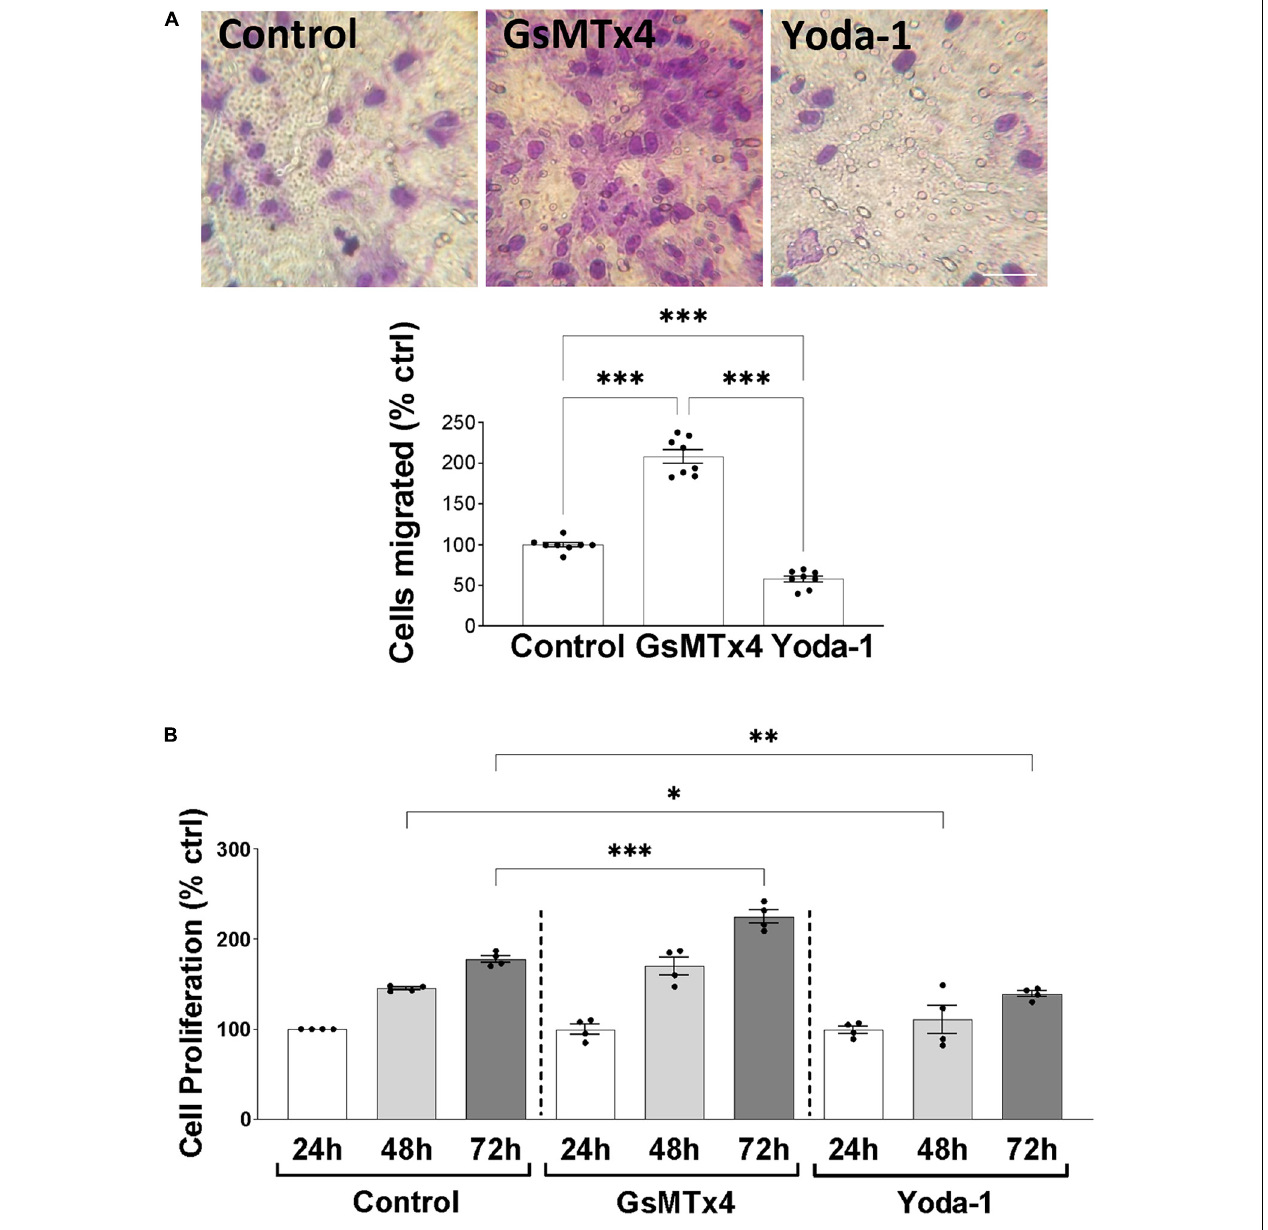
FIGURE 3 | Inhibition of Piezo1 induces MO3.13 oligodendrocyte migration. (A) Representative images and a corresponding bar graph show increased oligodendrocyte migration after inhibition of Piezo1 signaling for 24 h with GsMTx4 (500 nm) (208.4 ± 8.21% vs. control). Agonism of Piezo1 with Yoda-1 (40 µ m) induced opposite effects (58 ± 3.82% vs. control). Data presented as mean ± SEM, One-way analysis of variance and Tukey’s multiple comparisons test, ∗∗∗ p < 0.001, N = 8. Scale 25 µ m. (B) The MTT cell proliferation assay showed significantly increased cell proliferation after 72 h of Piezo1 inhibition with GsMTx4 (224.8 ± 7.50% vs. control) with no differences compared to the 24 and 48 h controls. Activation of the receptor with Yoda-1 significantly reduced cell proliferation after 48 (110.8 ± 15.58% vs. control) and 72 h (139.0 ± 3.34% vs. control). Data presented as mean ± SEM, One-way analysis of variance and Sidak’s